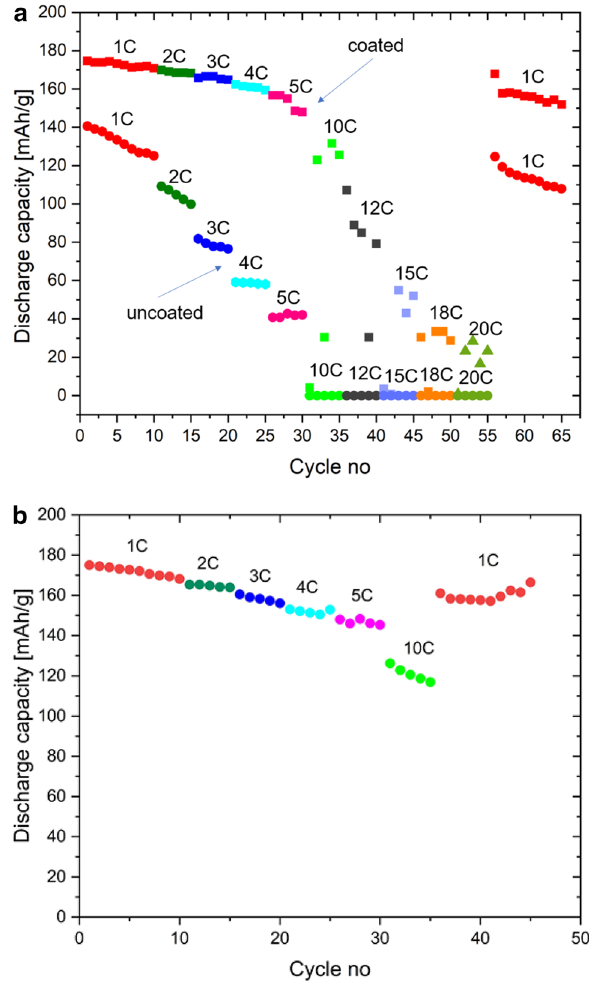
Fig. 3 a Discharge capacities of LFP cathodes with carbon-coated current collector, and uncoated current collector, measured at dif- ferent C-rates in the voltage window 2.5–4 V. b Discharge capacities of LFP cathodes with carbon-coated current collector measured at different C-rates in the voltage window 2.5–4 V at a temperature of 60